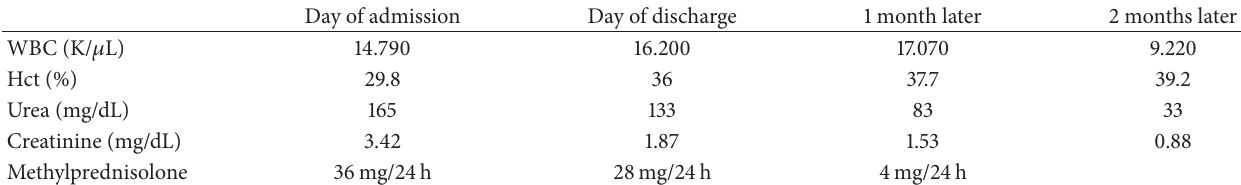
Table 2: Full blood count, kidney function, and steroid dose on admission and after